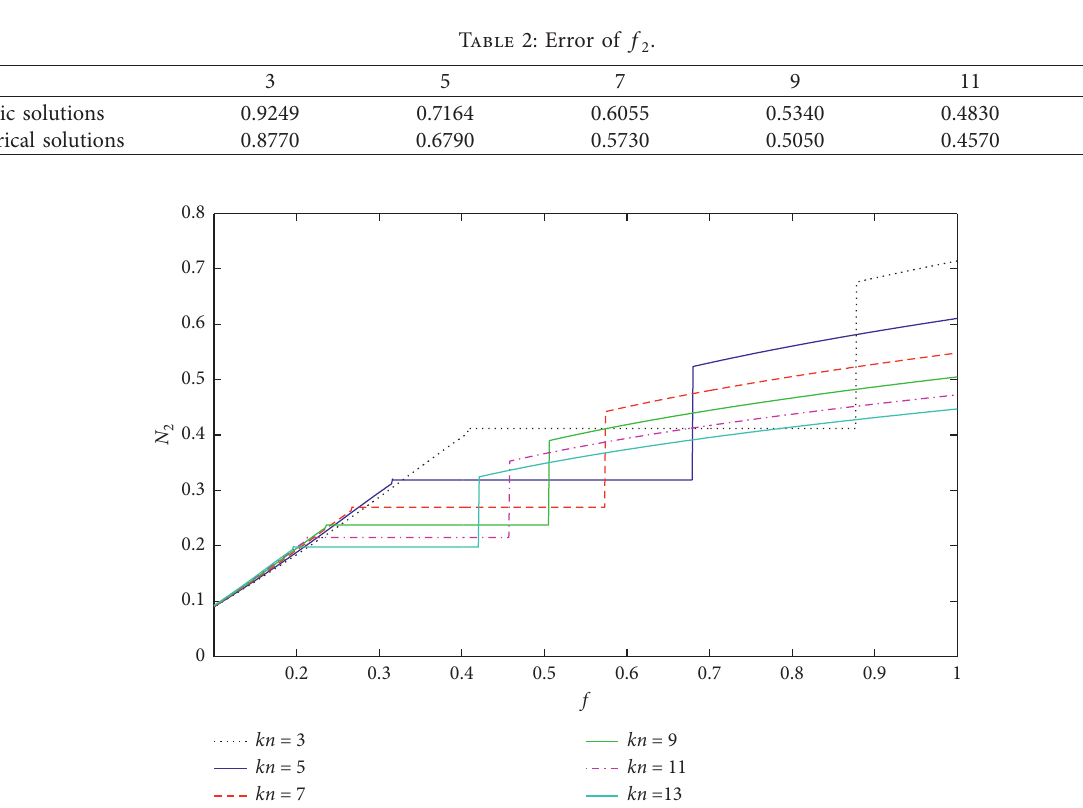
Figure 21: NES amplitude N